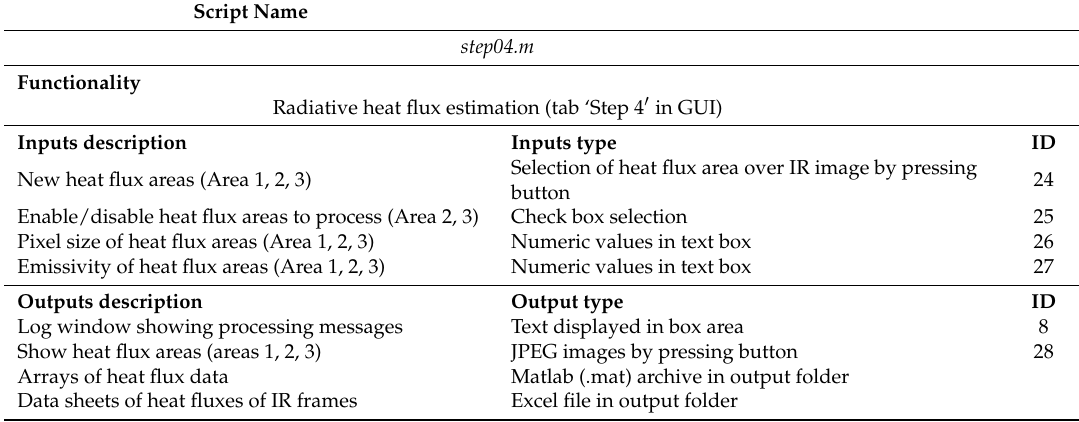
Table A5. Technical specifications of functionality and input/output data type of STEP